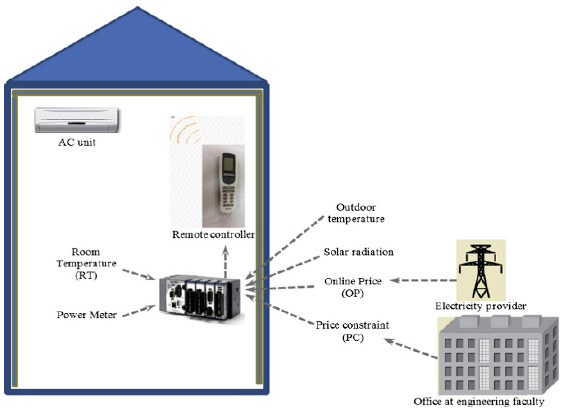
Figure 5. Control system used in Barzin et al. study [93].